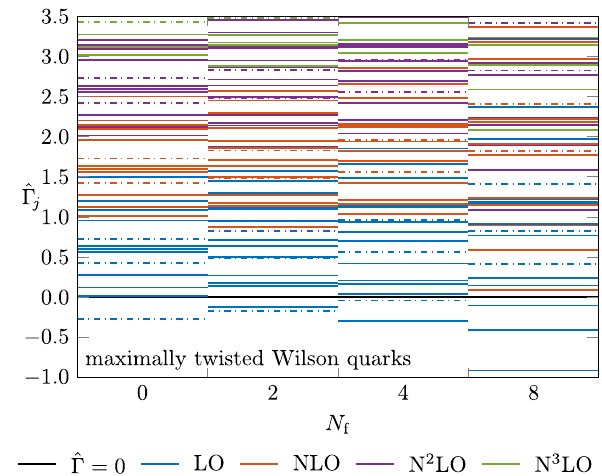
Fig. 4 Leading and subleading powers in the coupling ˆ (cid:2) j for the min- imal on-shell operator basis of Wilson quarks with maximal chiral twist and mass-degenerate flavour doublets. Only the case without explicit O ( a ) improvement is plotted as the case with improvement is identical to O ( a ) improved Wilson quarks, see Fig. 3. These powers describe the leading order lattice artifacts for spectral quantities at N f = 0 , 2 , 4 , 8. N f = 8 is added to highlight what happens when one gets closer to the conformal window. Again the solid lines correspond to the overall massless operator basis (possibly containing massive mixing contribu- tions), the dash-dotted lines belong to the operators with overall mass- dependence. In case the tree-level coefficient vanishes the first power plotted is regarded as NLO in the colour coding. Due to overlapping numerical values leading powers may be hidden by the “subleading” powers of other operators. Notice that we do not know the tree-level matchingcoefficientsforthemassivecase,whicharethereforeassumed to be non-vanishing. For the fully quenched case N f = 0, the